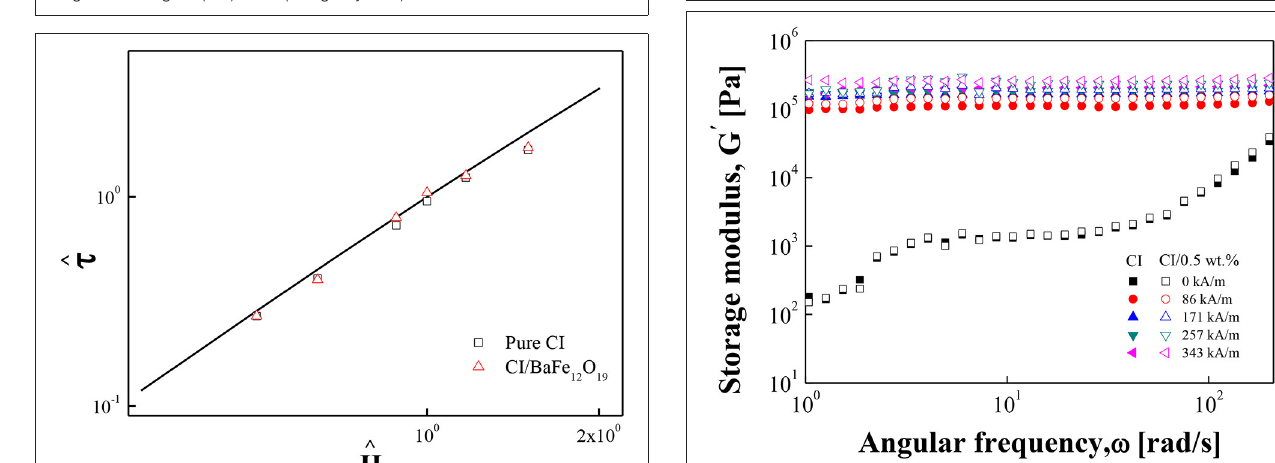
τ vs . ˆ H for pure carbonyl iron (CI; square symbol) FIGURE 5 | Universal plot of ˆ and CI/BaFe 12 O 19 mixture-based magnetorheological (MR) fluids (triangle symbol). The solid line is obtained using Equation (7).